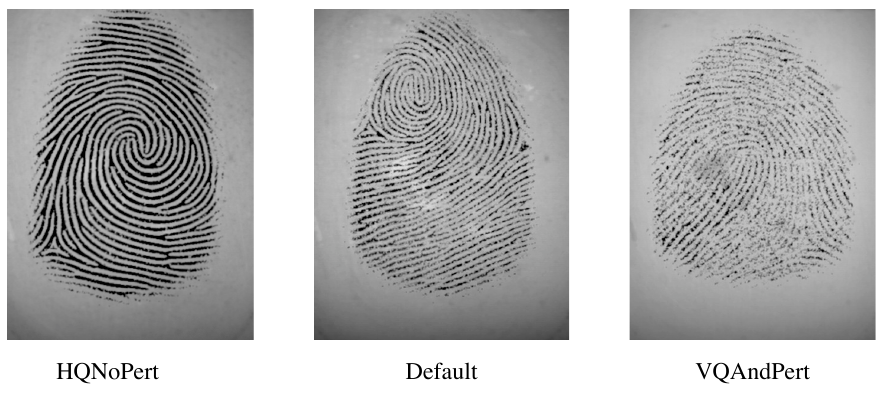
Figure 3. Fingerprint examples of the different studied databases.